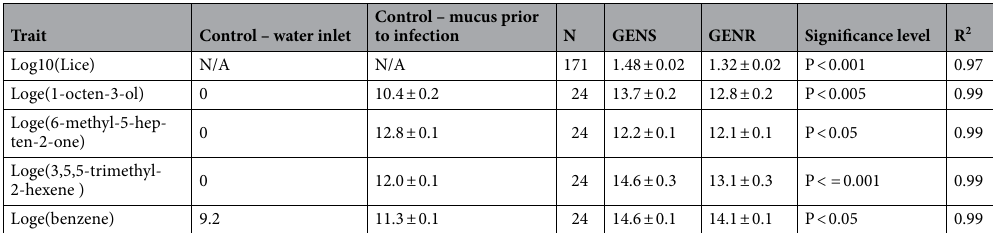
Table 2. The effect of Genetic lines susceptible (GenS) and resistance (GenR) to salmon lice infection on lice counts and mucosal VOC expression. Trait – Lice is count, VOC measured as integrated GC peak area, Control – water inlet = VOC in a single water sample from the inlet, Control – mucus prior to infection = VOC in 10 random samples before the fish were challenged with lice, N = number of fish sampled, GenS = the genetically susceptible line, GenR = genetically resistant line. R 2 = coefficient of determination. Standard errors given after estimates and ± .